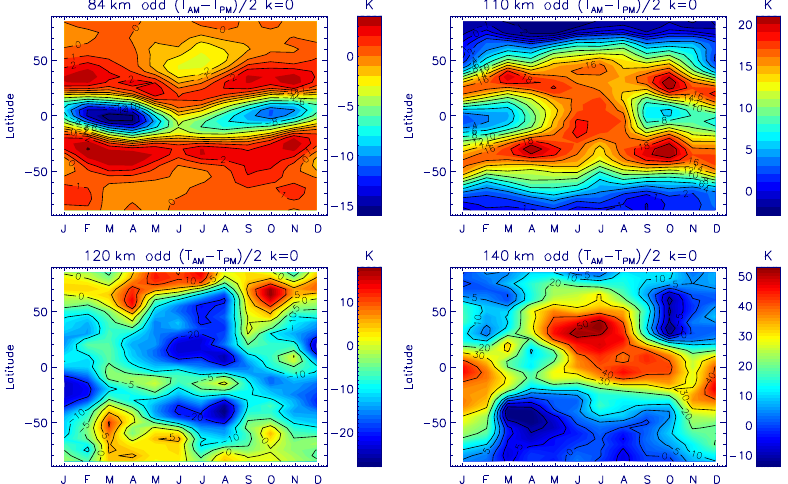
Figure 5. Time series of the latitudinal distribution of average (2007–2012) monthly zonal mean (cid:49)T/ 2 ( | n odd − s | = 0 mode) at 84, 110, 120 and